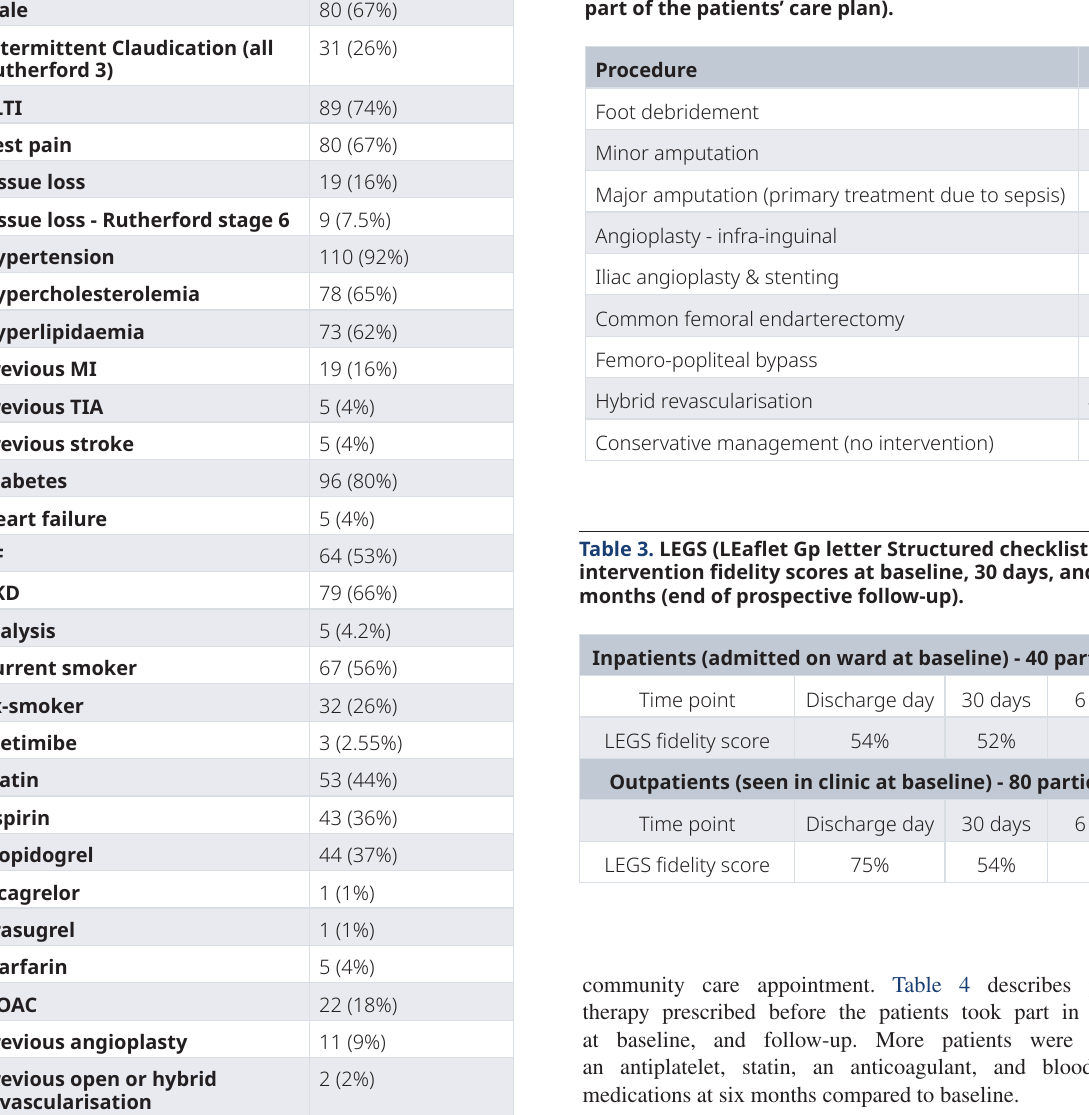
Table 5 and Table 6 describe secondary outcome measures